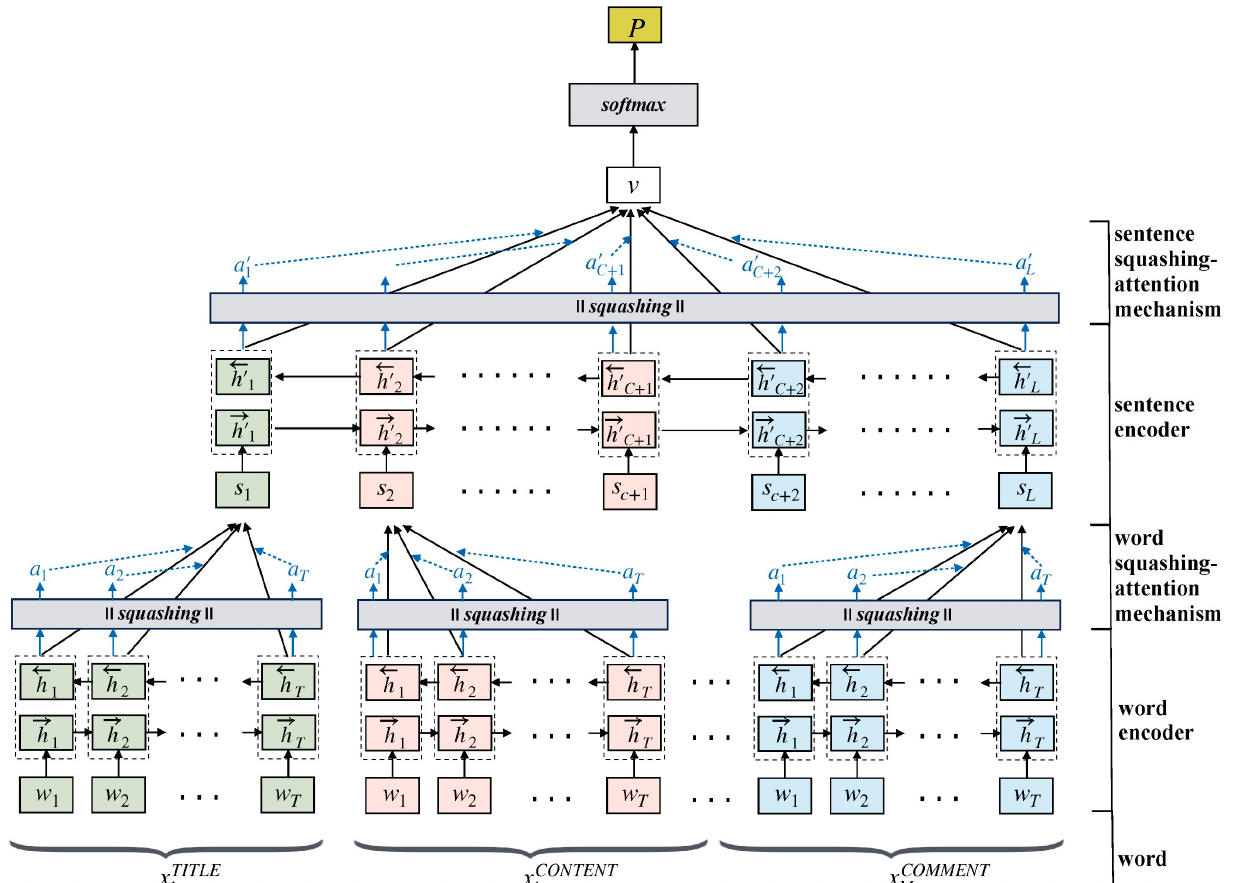
Figure 3. Proposed HSAN for cyberbullying detection.